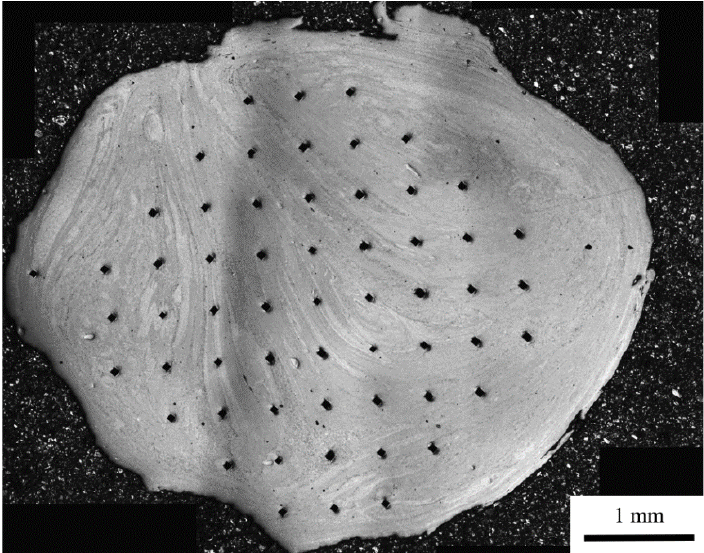
Figure 8. Polarised light micrograph of as-extruded wire from CP-Ti Gr2 HDH powder in the swarf tooling. The indents are the result of microhardness testing.